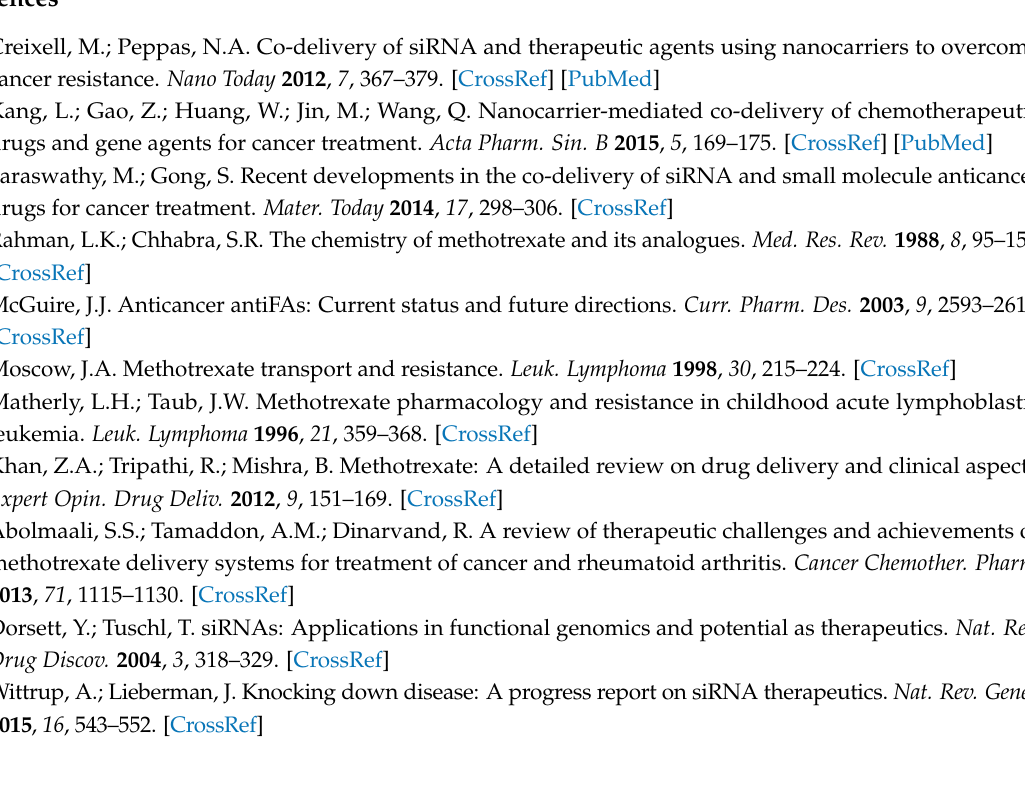
Figure S1. The synthesis procedure of the amphiphilic polymers. mPEG-LA was synthesized by the reaction of oleic acid chloride and mPEG-NH2 (A). MTX-bPEI-LA was synthesized by two steps (B). BPEI-LA was first synthesized, and then, the MTX was conjugated to finally obtained MTX-bPEI-LA; Figure S2. The 1 H NMR of mPEG-LA. mPEG-LA was dissolved in CDCl 3 and measured in a nuclear magnetic resonance instrument (500 MH Z ). The characteristic peaks of mPEG and LA were marked with the colour characters A, B, C, D, E, and F; Figure S3. The 1 H NMR of bPEI-LA. bPEI-LA was dissolved in CDCl 3 and measured in a nuclear magnetic resonance instrument (500 MH Z ). The characteristic peaks of bPEI and LA were marked with the colour characters A, B, C, D, E, and F; Figure S4. The 1 H NMR of MTX-bPEI-LA. MTX-bPEI-LA was dissolved in D 2 O and measured in a nuclear magnetic resonance instrument (500 MH Z ). The characteristic peaks of bPEI, MTX, and LA were marked with the colour characters A, B, C, D, E, F, and G; Figure S5. The in vitro siRNA release profile of FAM-siRNA-loaded mixed micelles in PBS (pH = 7.4); Figure S6. The hemolytic analysis of M-MTX and MTX-bPEI-LA on murine erythrocytes (n = 3, mean ± SEM). 200 µ L various concentrations of M-MTX and MTX-bPEI-LA were incubated with 1 mL erythrocytes in a 2% phosphate buffer saline for 3 h. The suspensions were centrifuged, and the absorbance of supernatant (100 µ L) was measured at 450 nm; Figure S7. The cytotoxicity of M-MTX and MTX-bPEI-LA ( n = 3, mean ± SEM). The cells were plated in 96-well microtiter plates (5000 cells per well) and cultured overnight. M-MTX and MTX-bPEI-LA at 3 concentrations (1, 5, and 20 µ g/mL) were added. After another 24 h, the relative cell viability was determined and was presented as a percentage of the viability of untreated